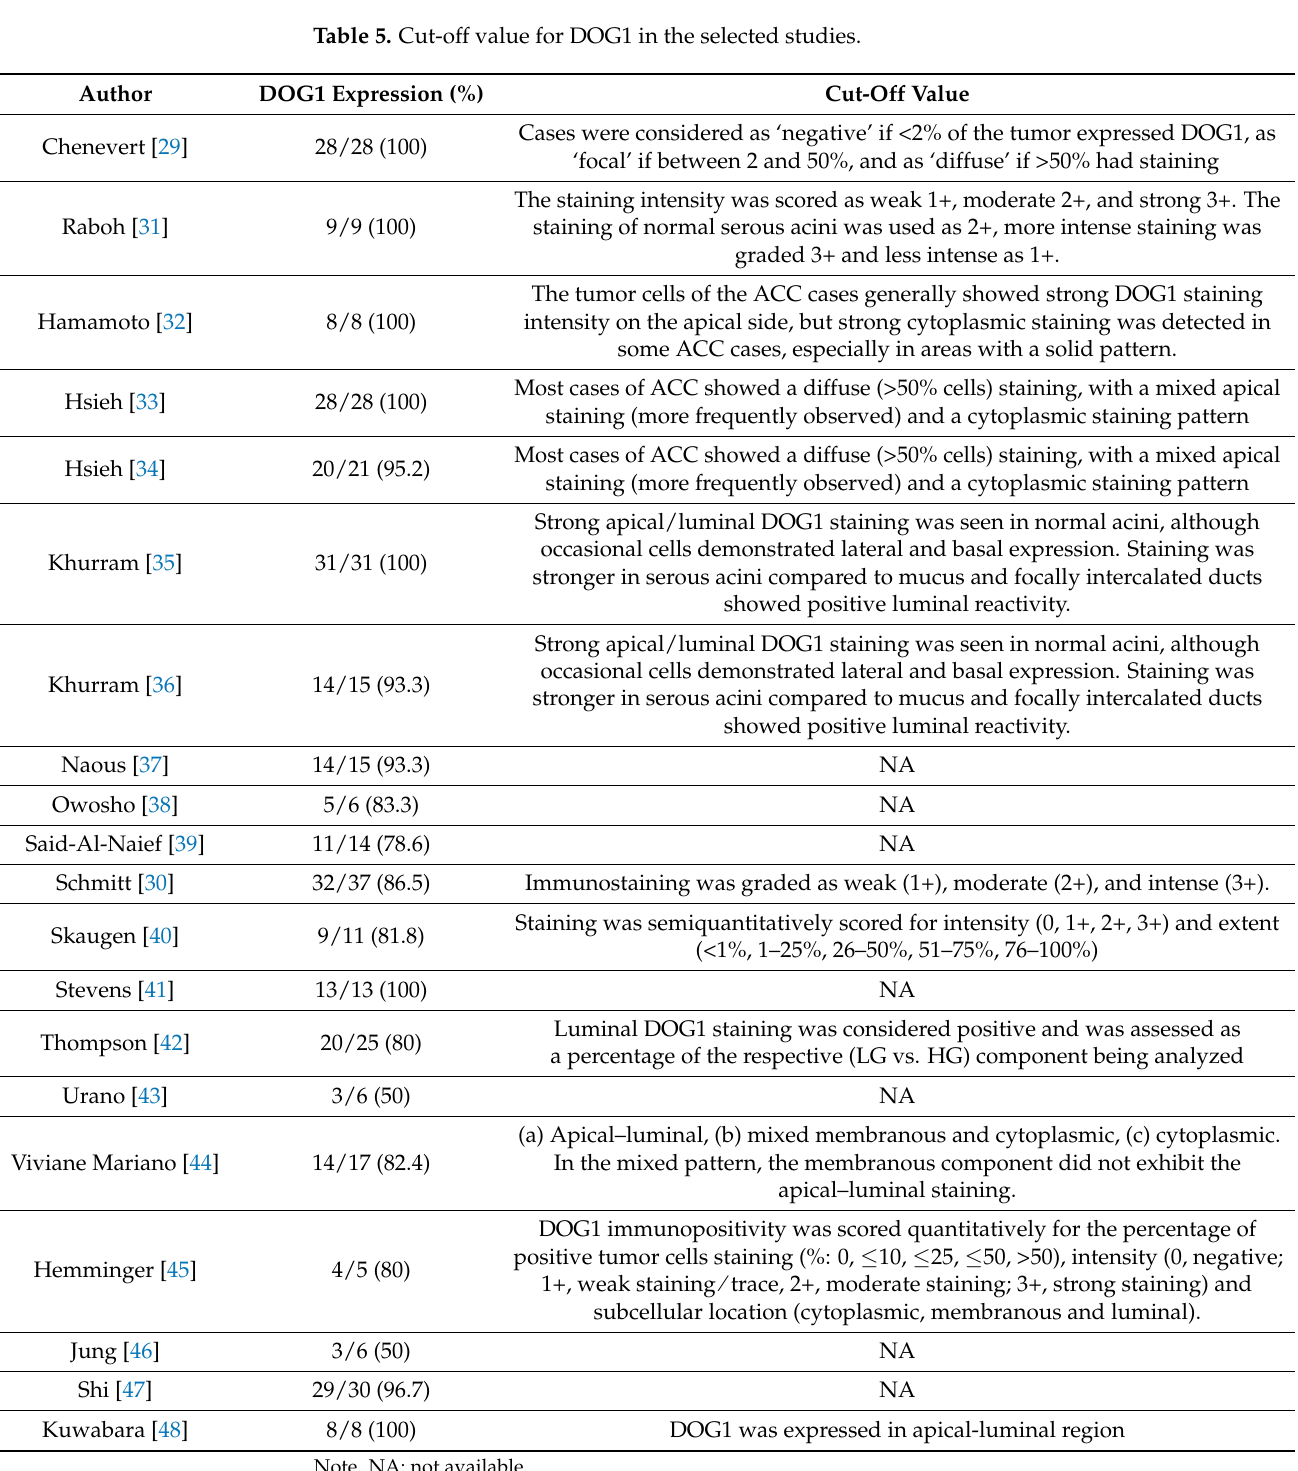
Table 5. Cut-off value for DOG1 in the selected